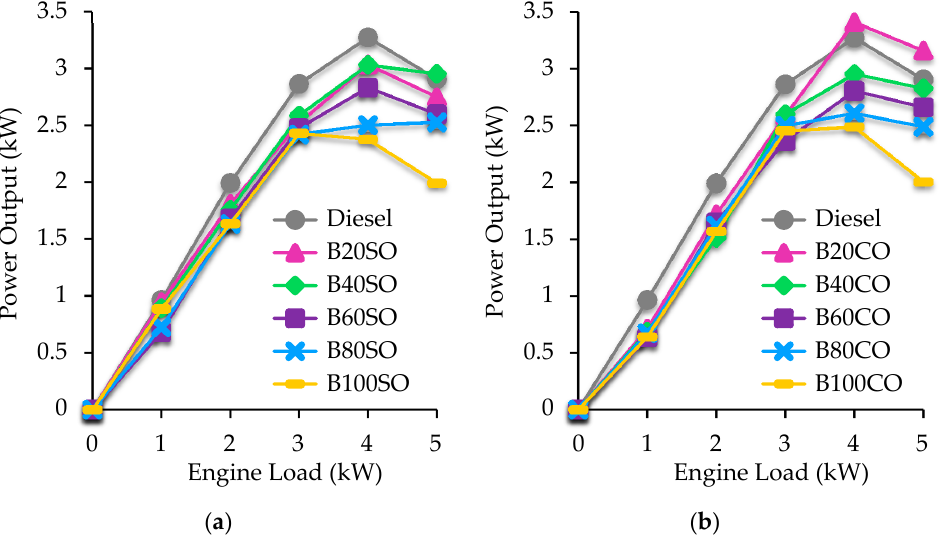
Figure 2. Power Output (W) versus engine load (0–5 kW), for the fuel blends: ( a ) DEC / SO and D / DEC / SO; ( b ) DEC / CO and D / DEC / CO. The errors in measurements are less than